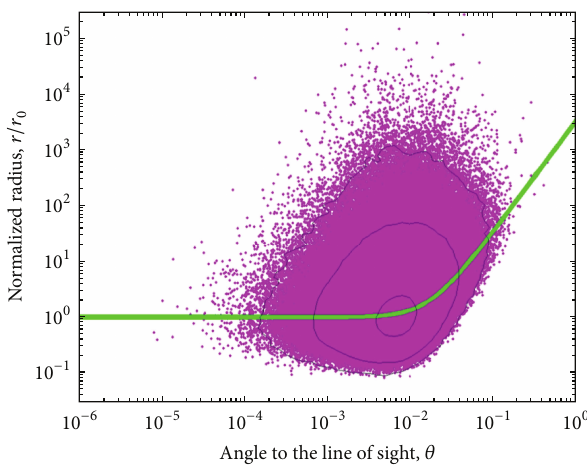
Figure 14: The green line represents the (normalized) photospheric radius 𝑟 ph asafunctionoftheangletothelineofsight, 𝜃 ,forspherical explosion (see (20)). The red dots represent the last scattering locations of photons ejected in the center of relativistic expanding “fireball” (using a Monte-Carlo simulation). The black lines show contours. Clearly, photons can undergo their last scattering at a range of radii and angles, leading to the concept of “vague photo- sphere.” The observed photospheric signal is therefore smeared both in time and energy. Figure taken from Pe’er